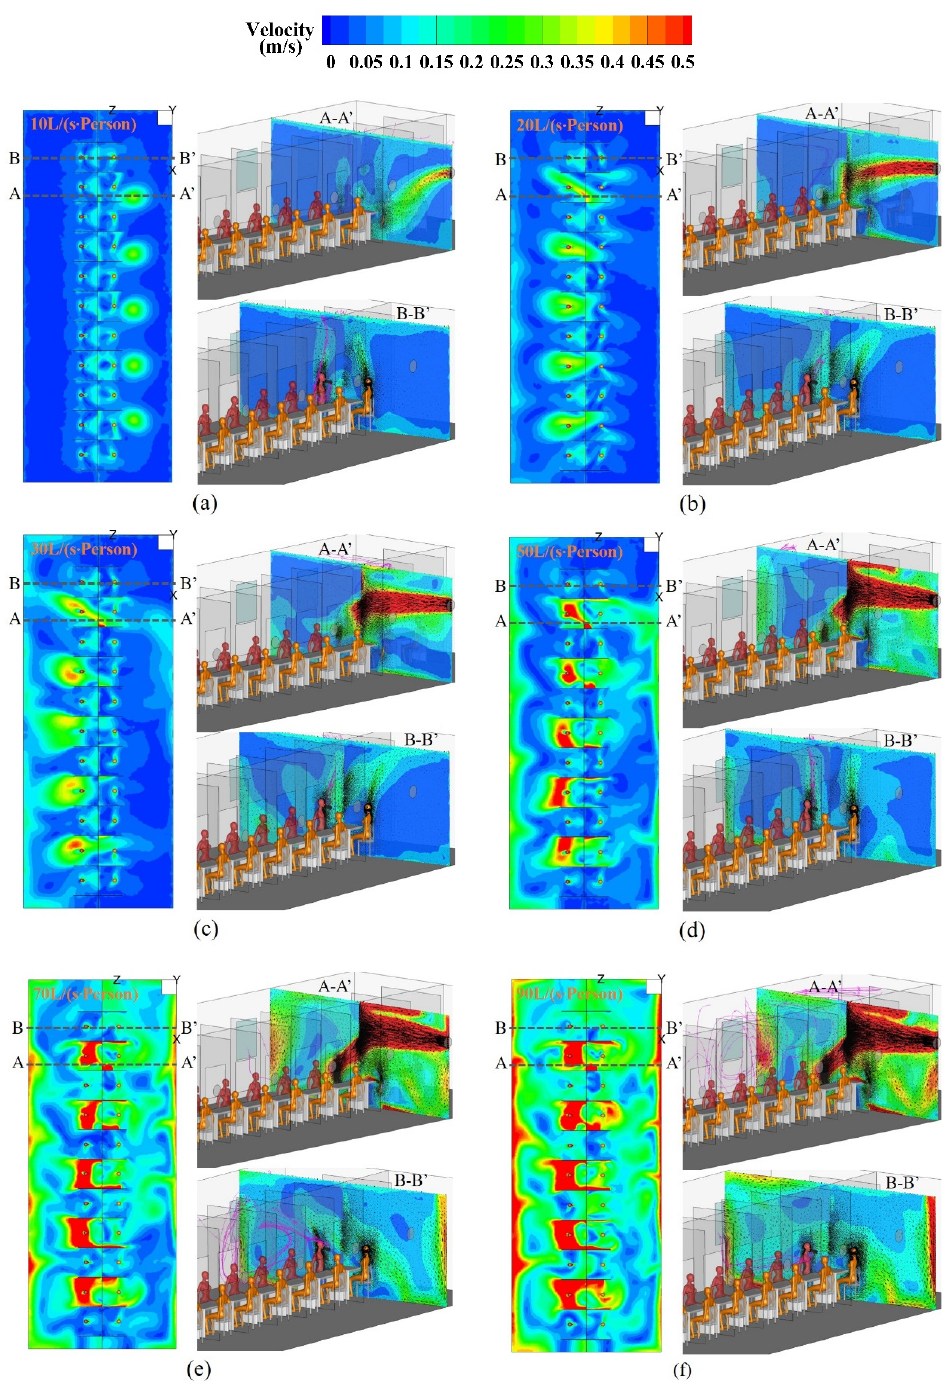
Figure 6. Airflow patterns at the planes of y = 1.1 m, x = 1.09 m, and x = 2.25 m under the MEFV with different ventilation rates: ( a ) 10 L/(s · Person); ( b ) 20 L/(s · Person); ( c ) 30 L/(s · Person); ( d ) 50 L/(s · Person); ( e ) 70 L/(s · Person); ( f ) 90 L/(s · Person).